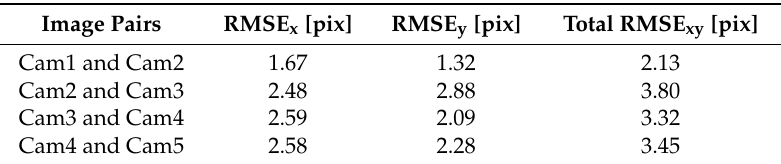
Table 6. Results from multi-camera matching.